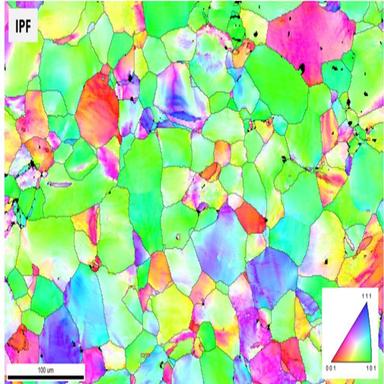
Typical microstructure of the alloy prior the test (EBSD Inverse Pole Figure map) on radial-circumferential (hoop) crossection. The IPF map is colored in normal direction (Z); the IPF color key is the same for all IPF maps through the paper.